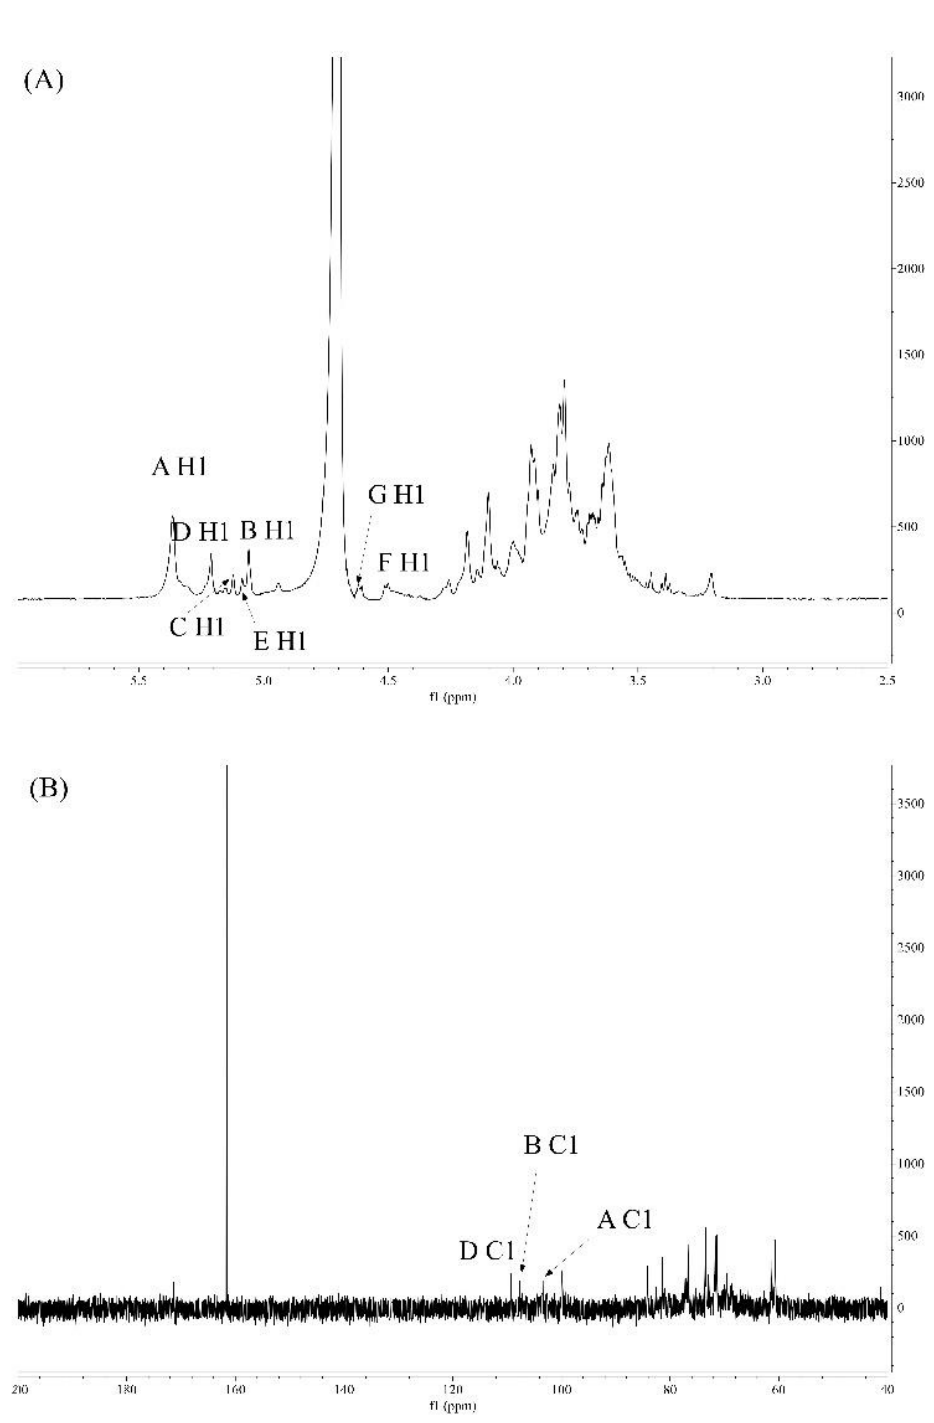
Figure 6. One-dimensional NMR studies of JSP-1. ( A ) 1 H NMR spectrum; ( B ) 13 C NMR spectrum.